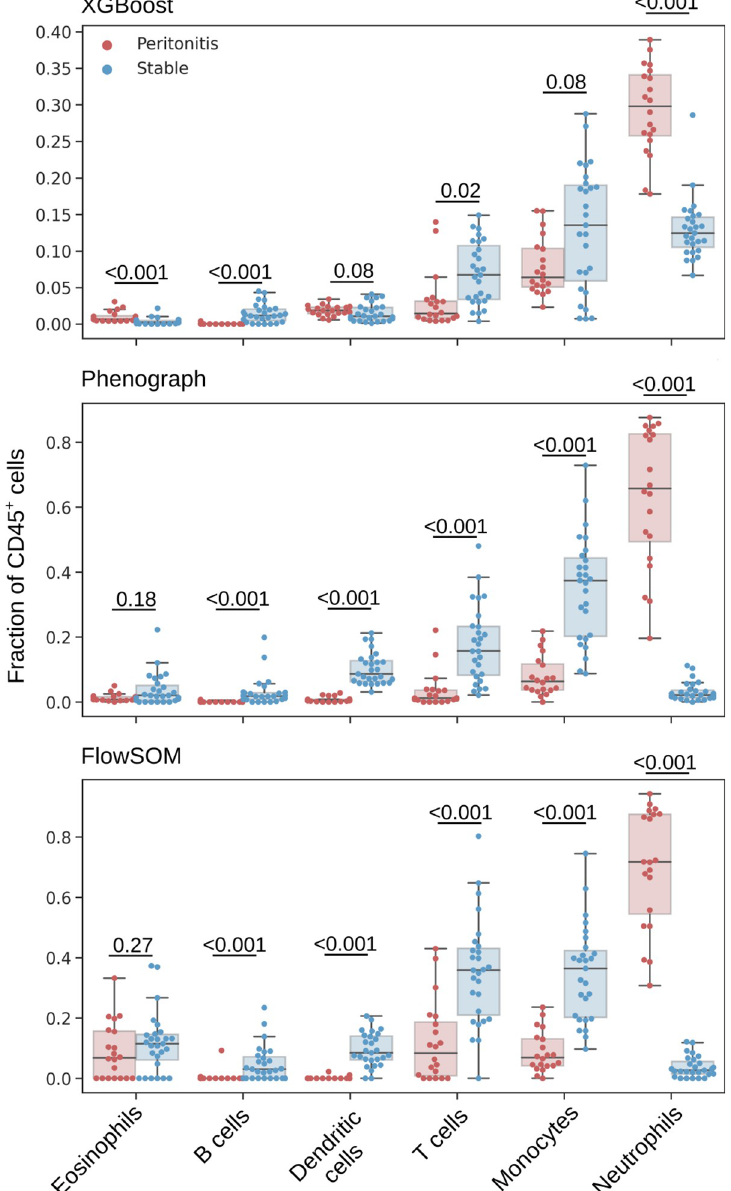
Fig 8. Leukocyte subsets as a fraction of CD45 + cells as identified by an XGBoost classifier (top), Phenograph clustering (centre) and FlowSOM clustering (bottom). Mann-Whitney U test were applied for comparisons between patients with acute peritonitis and stable controls, and p-values are reported after correction for multiple comparisons using Holm’s method (significance level was set as 0.05).